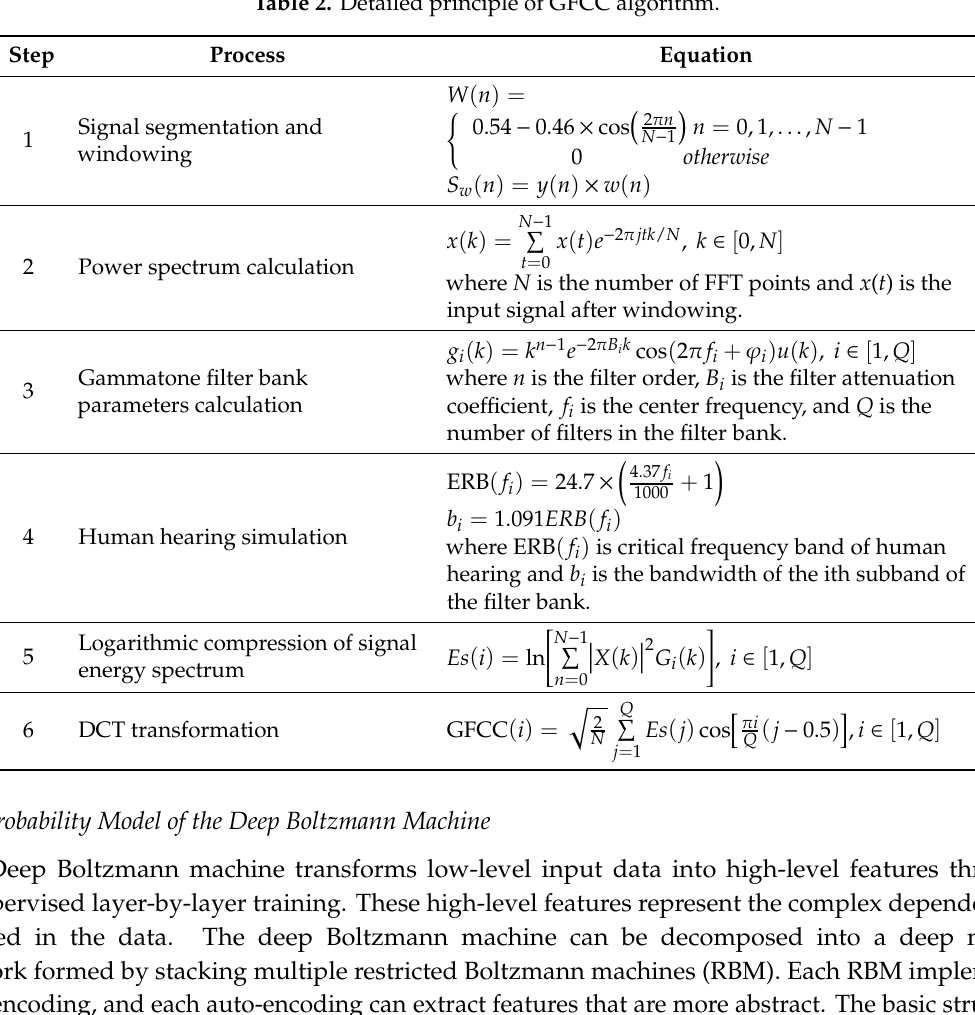
Table 2. Detailed principle of GFCC algorithm.